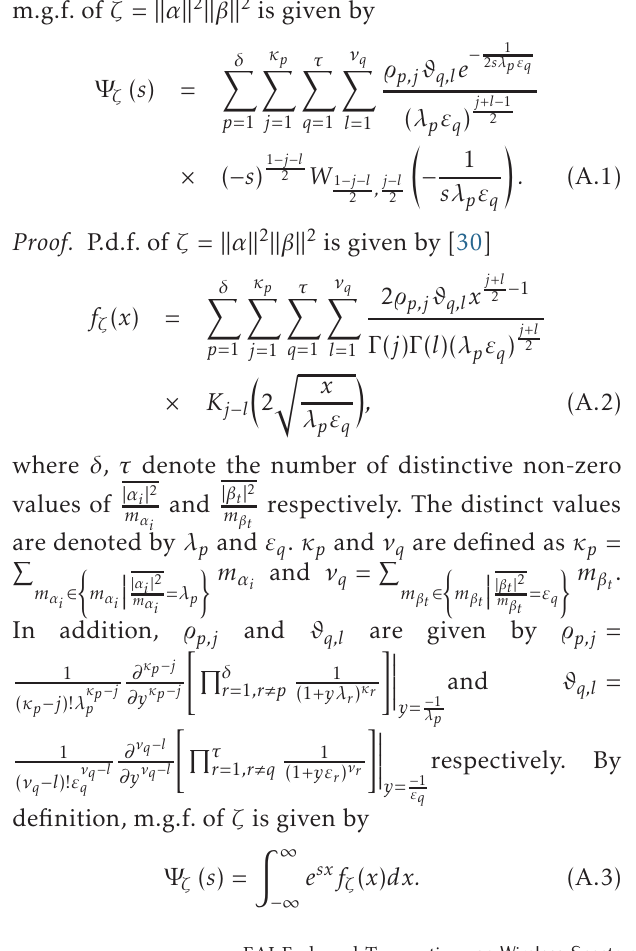
Figure 8. Outage probability performance of G fading parameters equal to 1